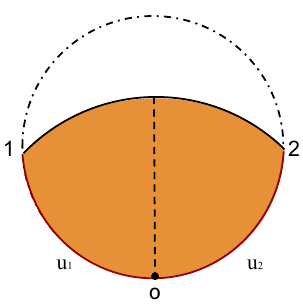
Figure 9 . WdW wavefunction with